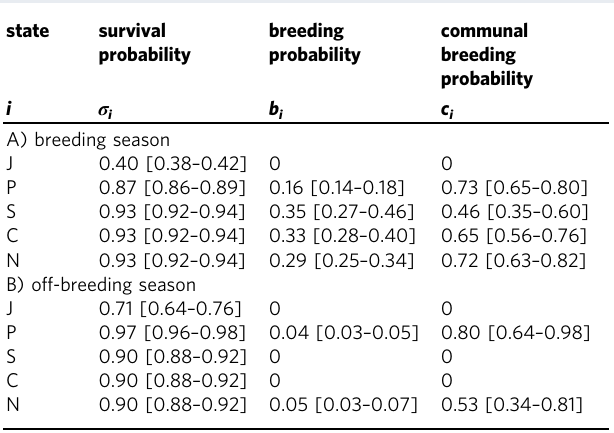
State-speci fi c monthly survival and breeding probabilities [95% CI] during the breeding season (Mar-Sep) and off-breeding season (Oct-Feb) estimated with the most parsimonious multi- state capture-mark-recapture model (MSCMR, see Table S1). Survival probability is the probability that females that are currently in state i survive until next month; breeding probability is the probability that females that are currently in state i will breed next month (i.e., produce a litter) either solitarily or communally, conditional on survival; and communal breeding probability is the probability that females that are currently in state i will breed communally, conditional on a female being alive and breeding next month. For a detailed description of life-history states, possible transitions among states and an explanation of the abbreviations, see Fig. 1, n = 4003